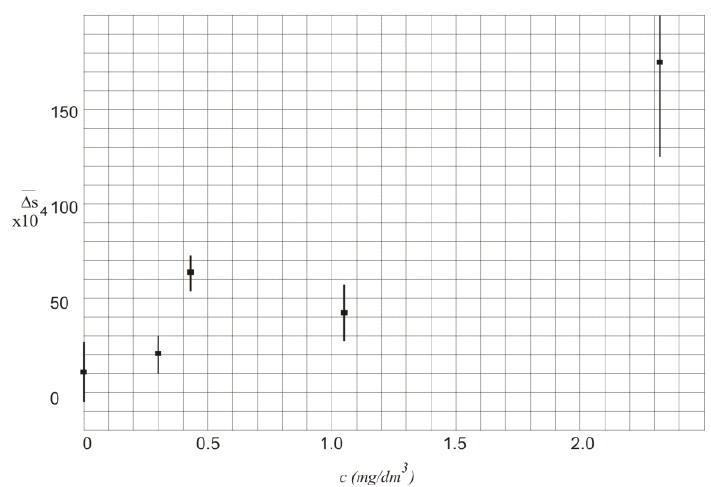
Figure 4. Values of ∆𝑠̅̅̅ in function of alcohol concentration c .